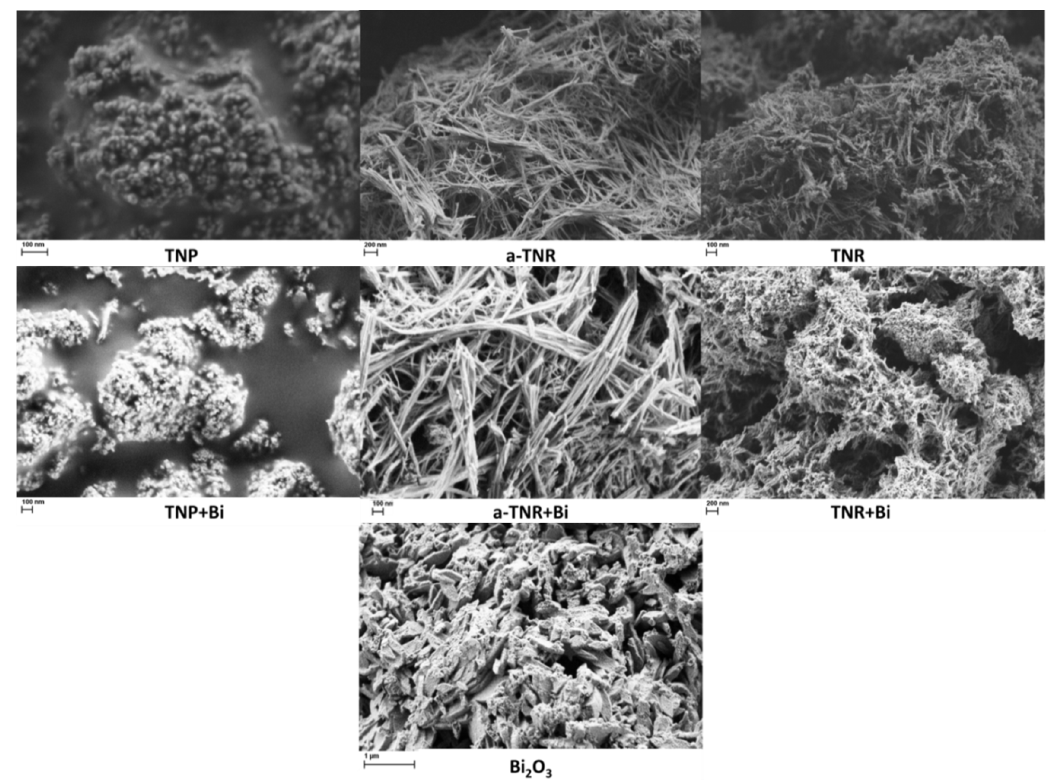
Figure 1. SEM micrographs of prepared catalysts.